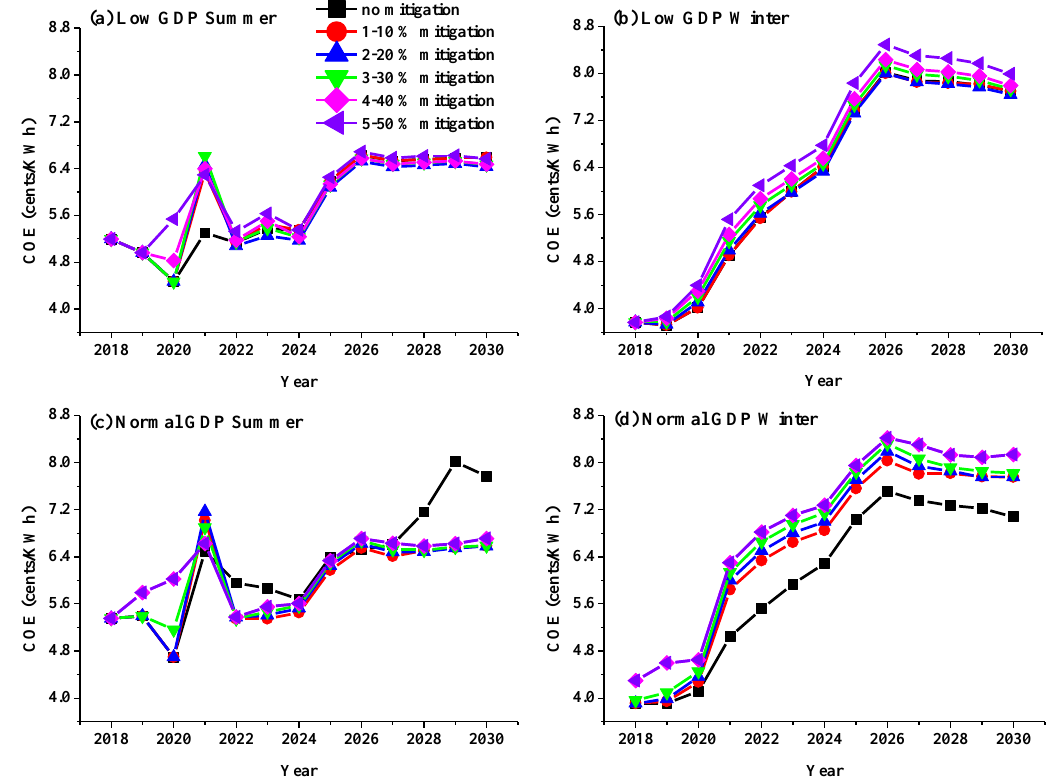
Figure 9. Cost of electricity for various CO 2 mitigation targets under fuel balancing.